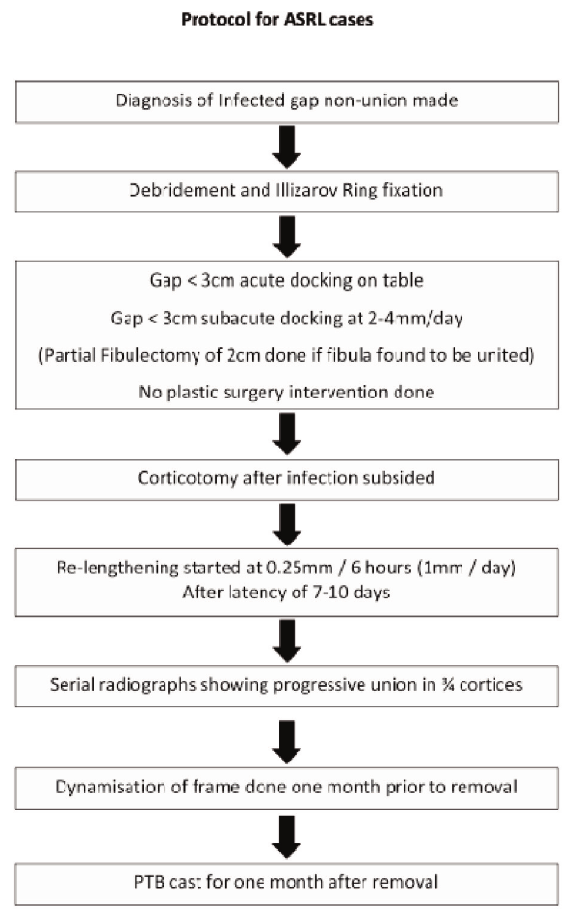
Protocol for Acute Shortening and Re-lengthening. Fig. 7: